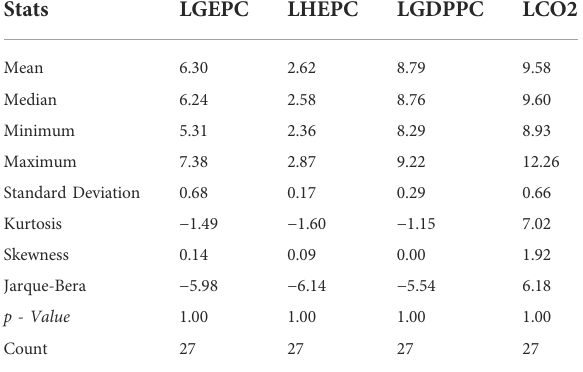
TABLE 1 Descriptive statistic.